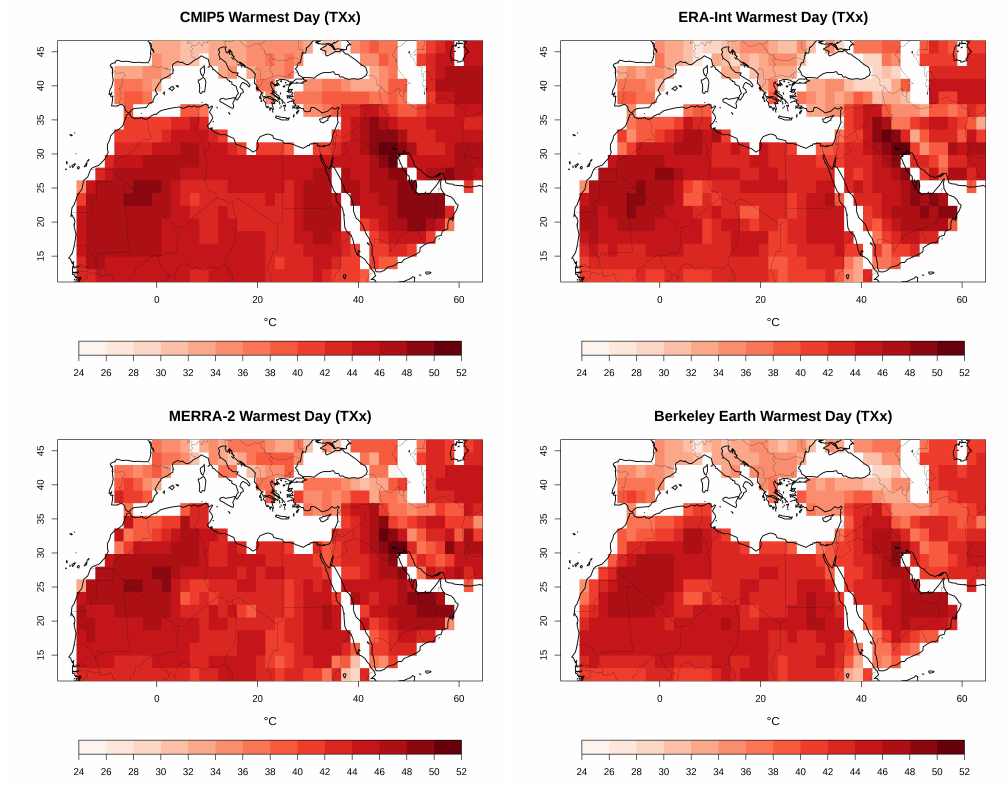
Figure 1. 1980–2018 climatology of the Warmest Day (TXx) for the: CMIP5 multi-model ensemble mean ( top left ), ERA-Interim ( top right ), MERRA-2 ( bottom left ), and Berkeley Earth ( bottom right